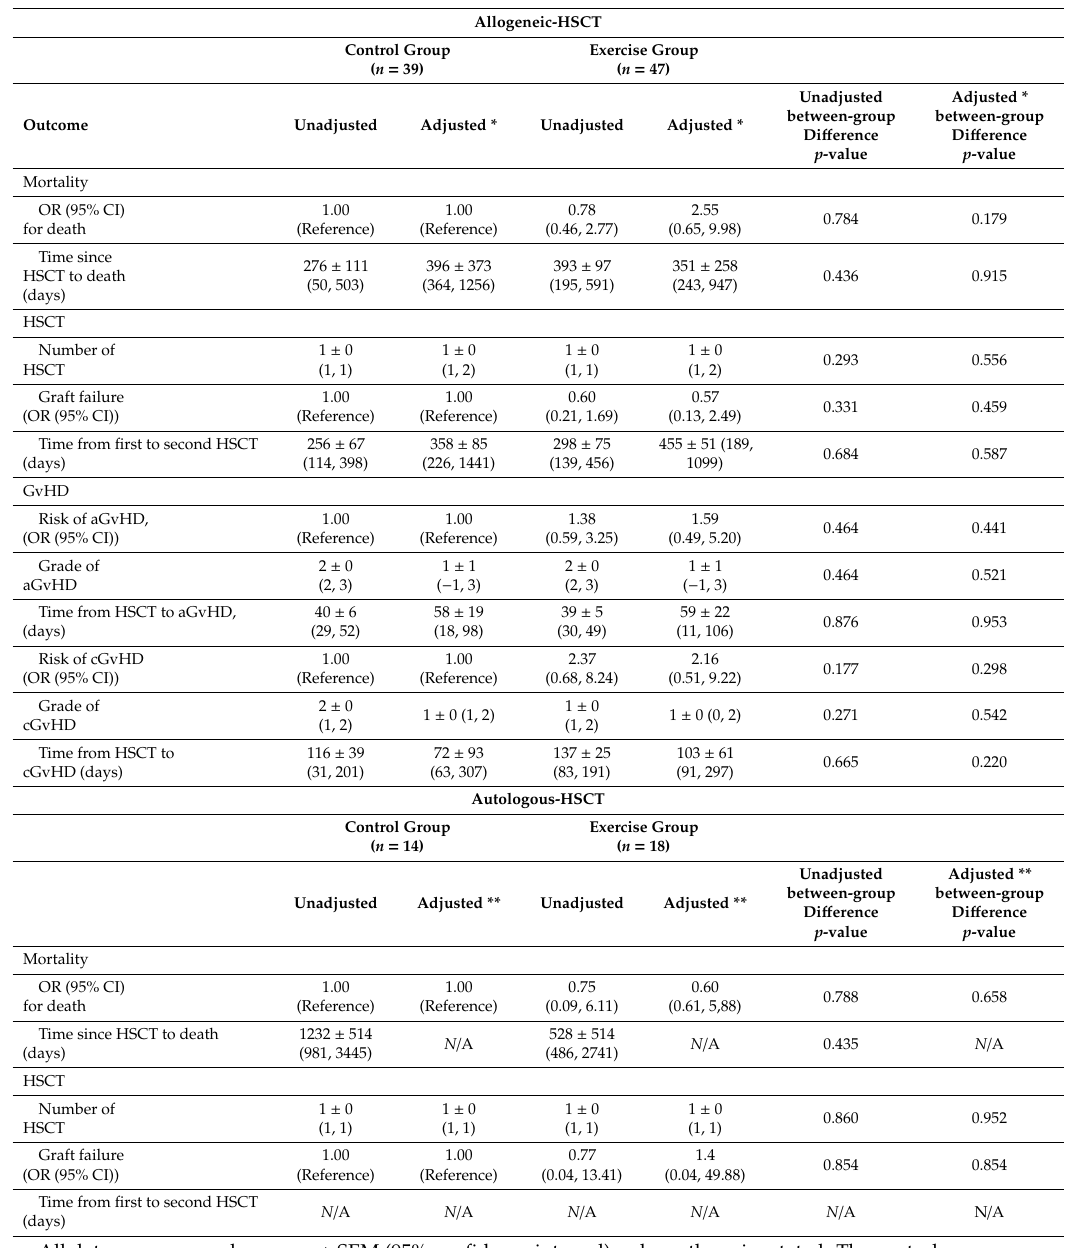
Table 2. E ff ects of exercise intervention on primary